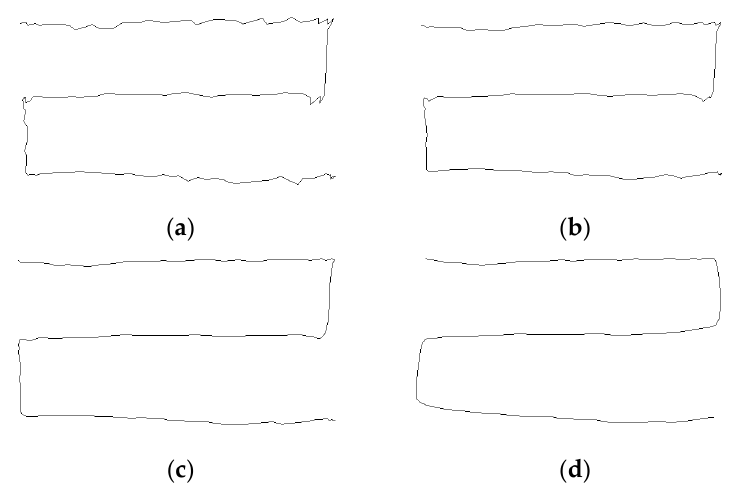
Figure 17. Path correction results according to filtering methods: ( a ) original touch paths; ( b ) correcting by low-pass filter; ( c ) correcting by Kalman filter; ( d ) correcting by proposed method.